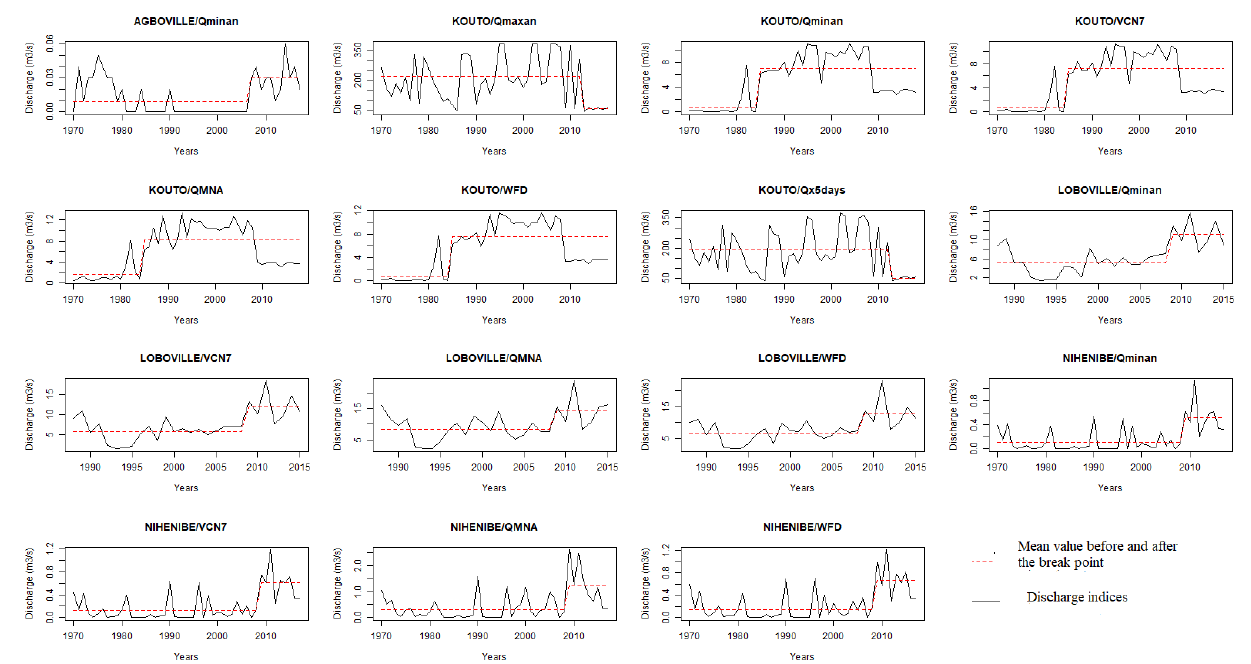
Figure 4. Significant break points in the selected watersheds in Côte d’Ivoire .